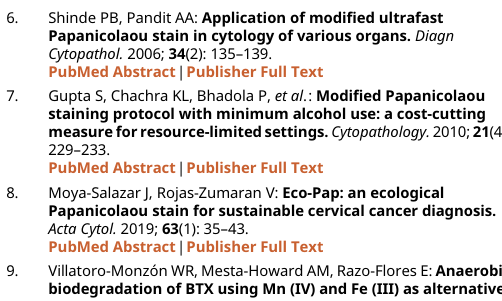
Figshare: ‘ Cost and pollution by the use of xylene in cervical cytology in four Peruvian hospitals ’ , https://doi. org/10.6084/m9.figshare.15048903.v1.